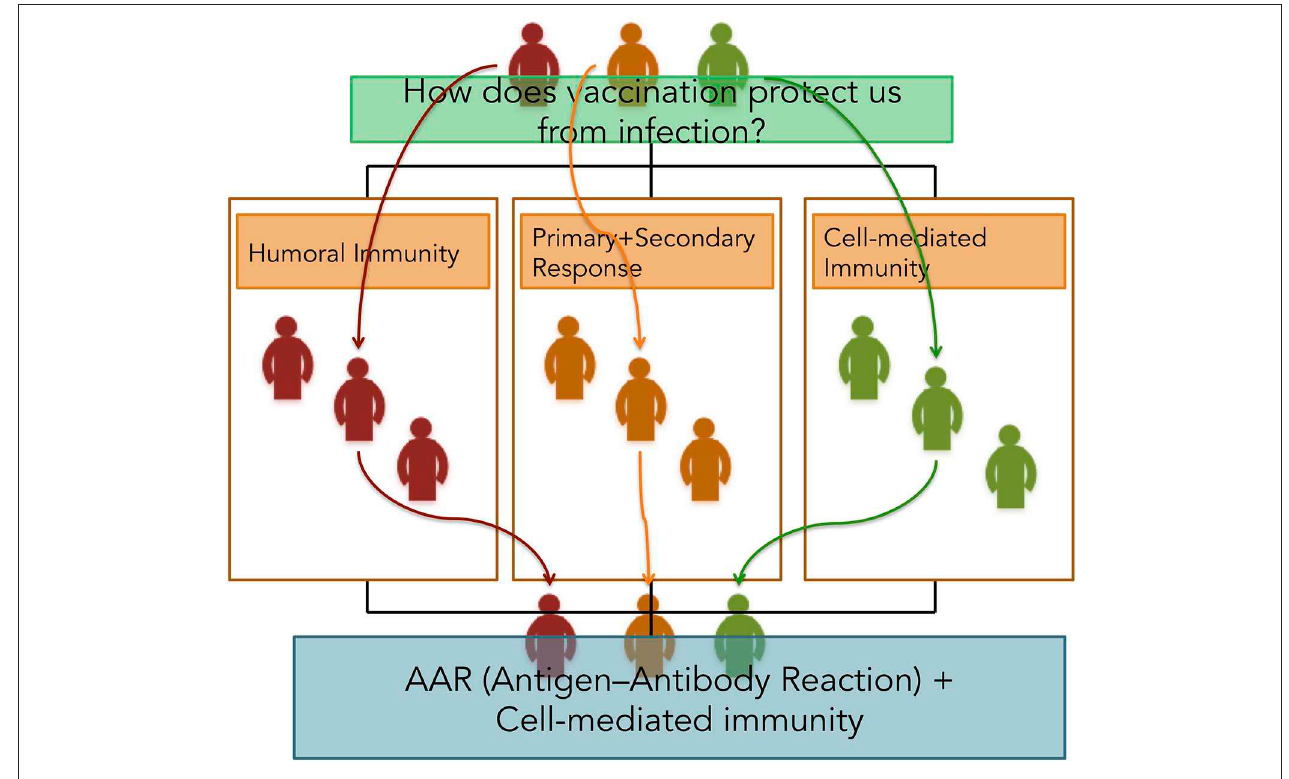
FIGURE 1 | The Jigsaw instruction designed in this